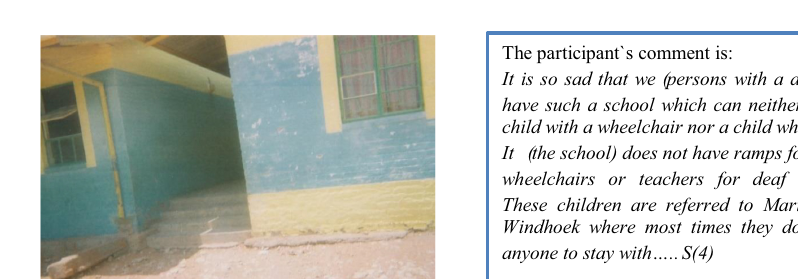
Figure 3. Physical and